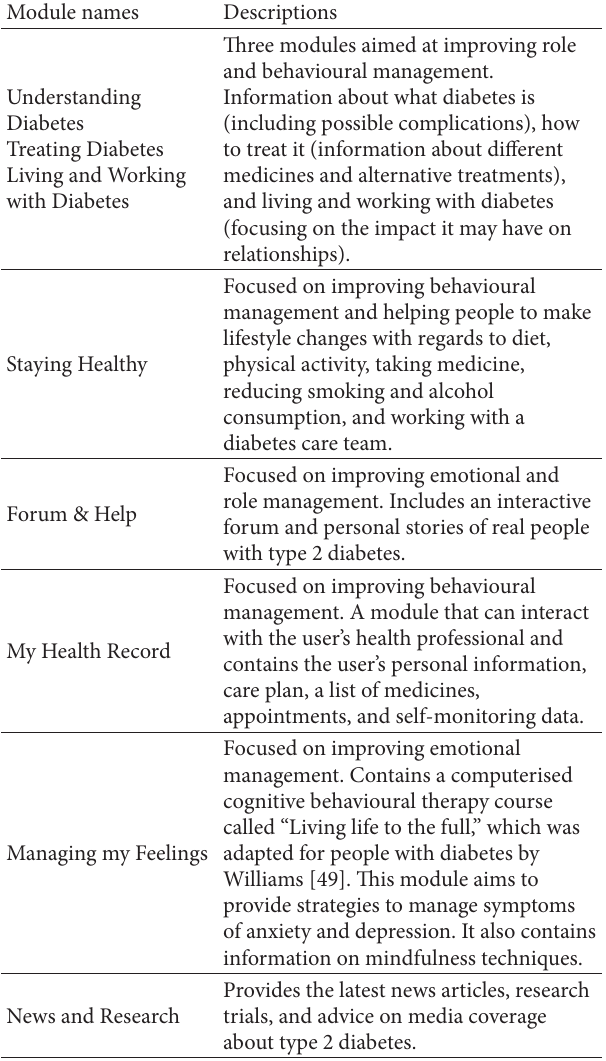
Table 3: HeLP-Diabetes module names and descriptions. Module